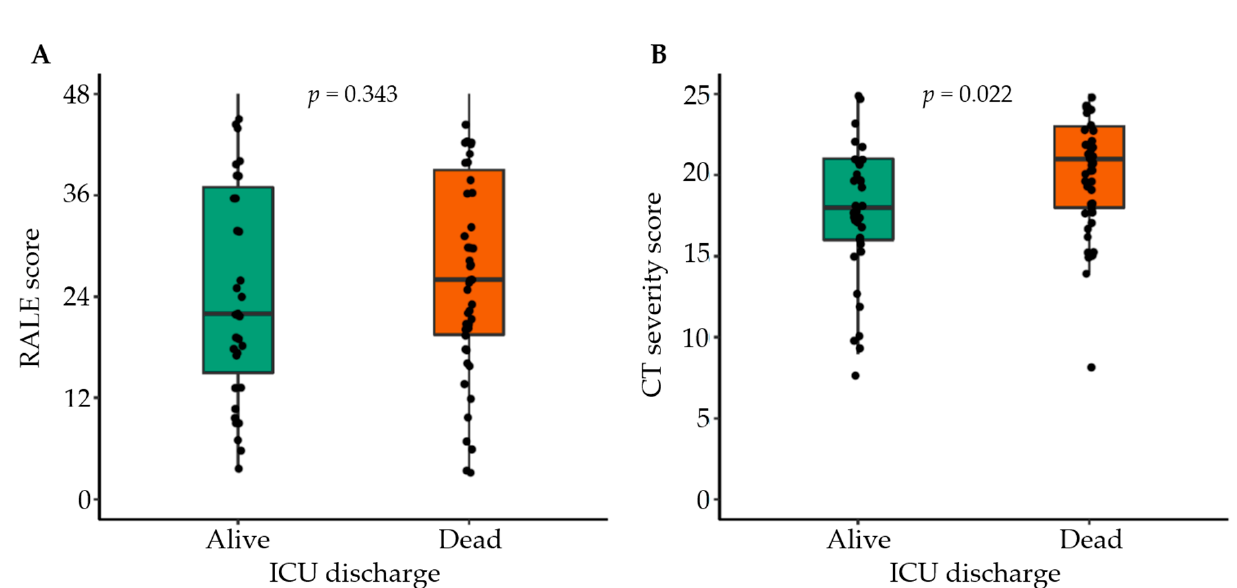
Figure 2. Boxplots of the ( A ) RALE score and ( B ) CTSS in survivors versus non-survivors.